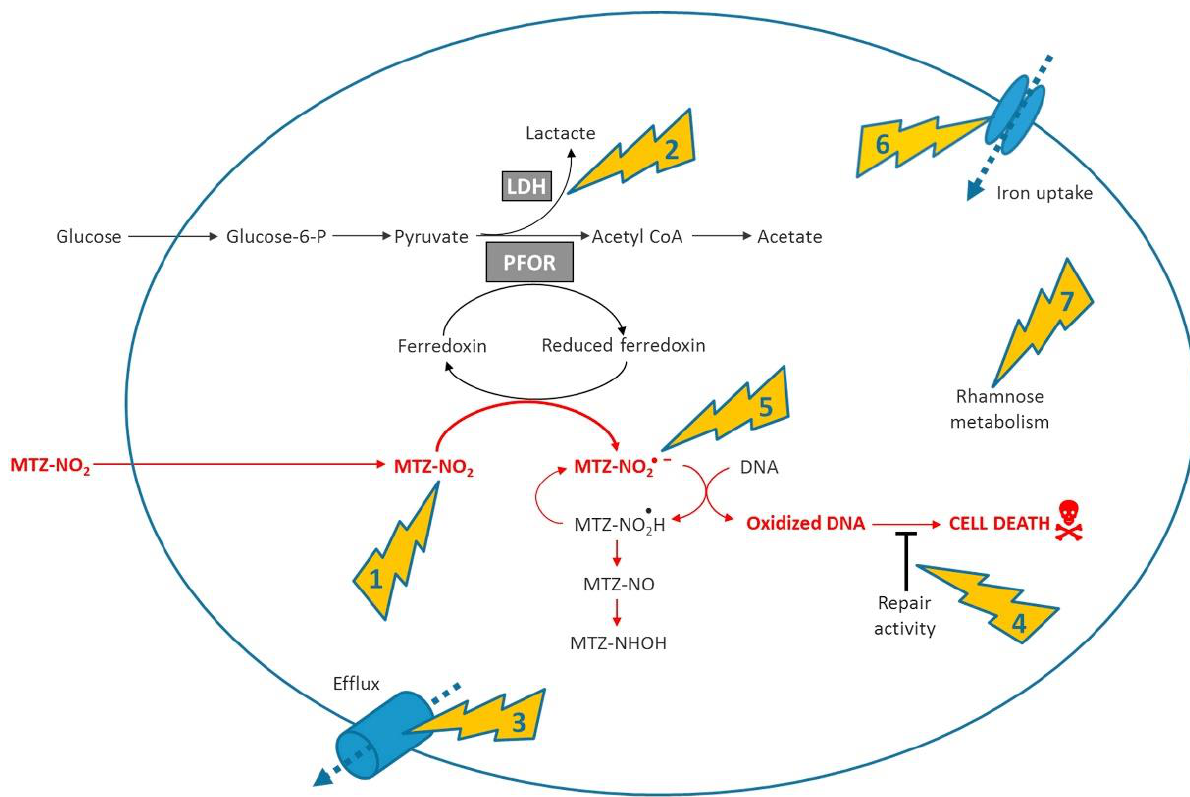
Figure 4. Summarised mode of action and main mechanisms involved in resistance. ( 1 ) Shows nitroimidazole reductase activity encoded by the nim genes, ( 2 ) metabolic shift away to the pathway related to conversion of pyruvate to lactate via lactate dehydrogenase ( 3 ) increased efflux of the antibiotic ( 4 ) increased DNA repair capacity ( 5 ) activation of antioxidant defense systems ( 6 ) deficiency of the ferrous iron transporter FeoAB, ( 7 ) overexpression of the rhamnose catabolism regulatory protein RhaR [50].